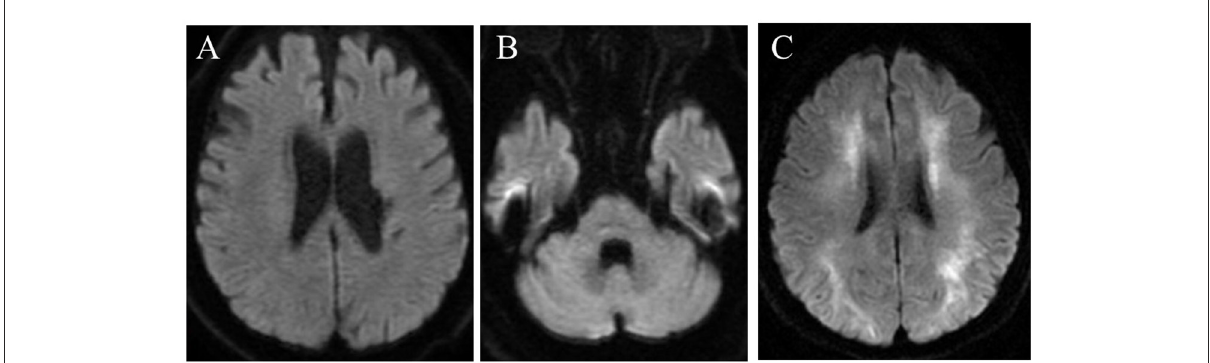
FIGURE1 Brain diffusion-weighted magnetic resonance imaging in the present case (at the age of 76 years) (A,B) and in another NIID patient at our institution with typical imaging findings of corticomedullary junction (C). No high-intensity signal is seen in the corticomedullary junctions (A) or cerebellar hemisphere (B)